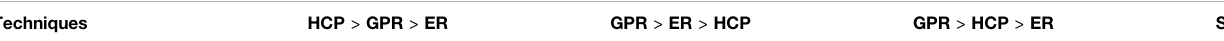
TABLE 3 | Comparison of weighted decision combination with various weight order in corrosion detection.